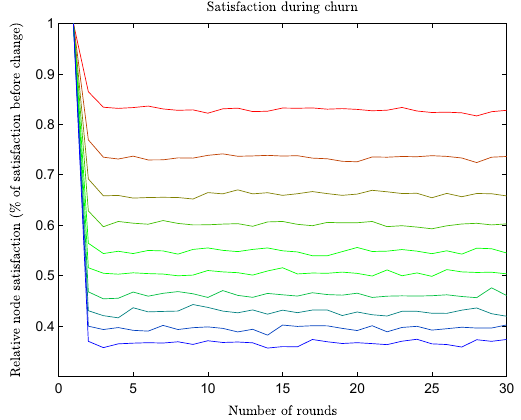
Figure 9. Satisfaction while churn is in progress, affecting 5% to 50% of the network’s nodes (in steps of 5%, top to